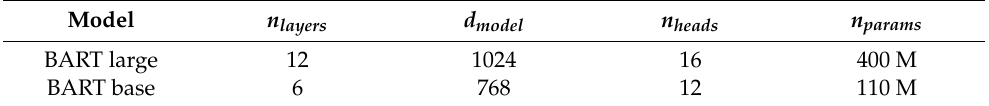
Table 1. Description of pre-trained BART models.